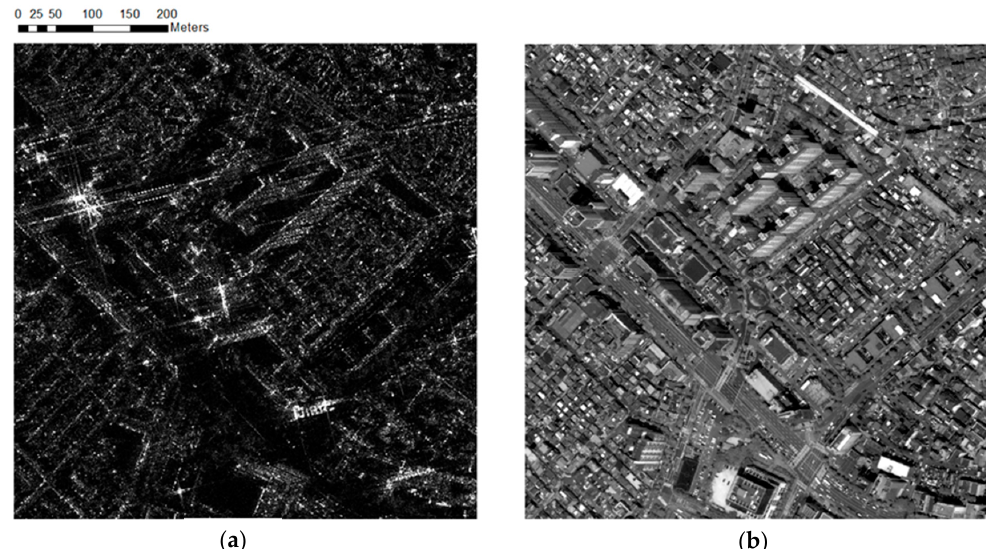
Figure 3. Experimental images from Site 2: ( a ) synthetic aperture radar image acquired on 10 September 2015; and ( b ) panchromatic image acquired on 7 August 2015.